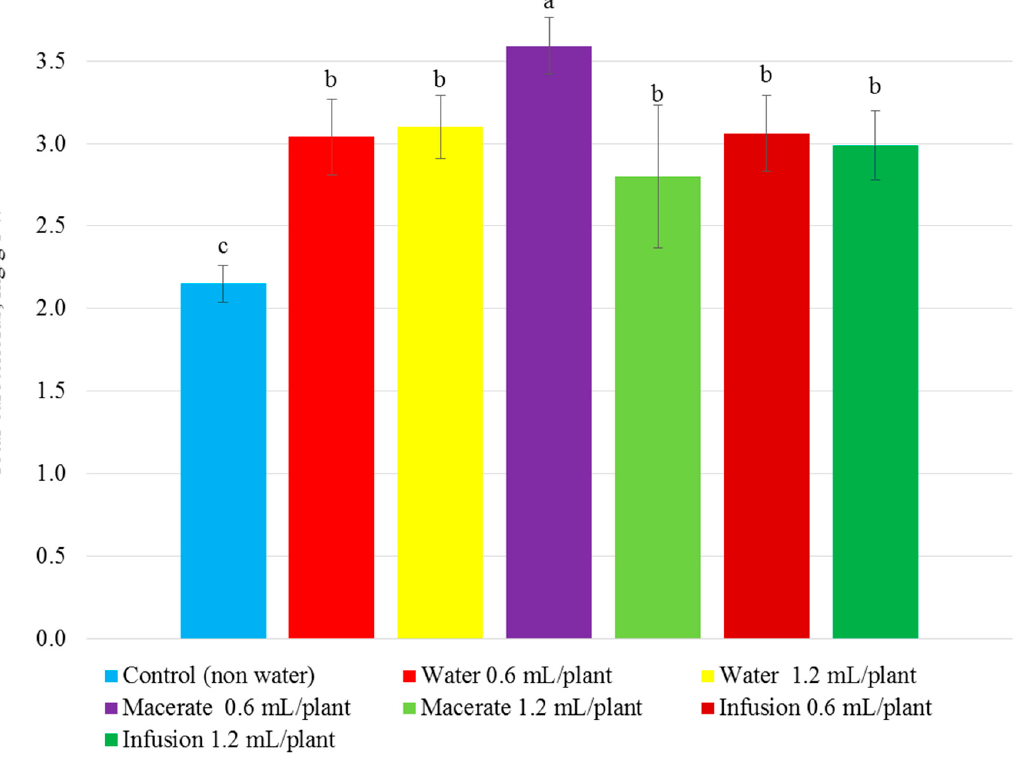
Figure 2. Concentration of carotenoids in potato leaves treated with extracts form Artemisia vulgaris L. (average of three independent experiments and SD). Values followed by different small letters are significantly different at p < 0.05.